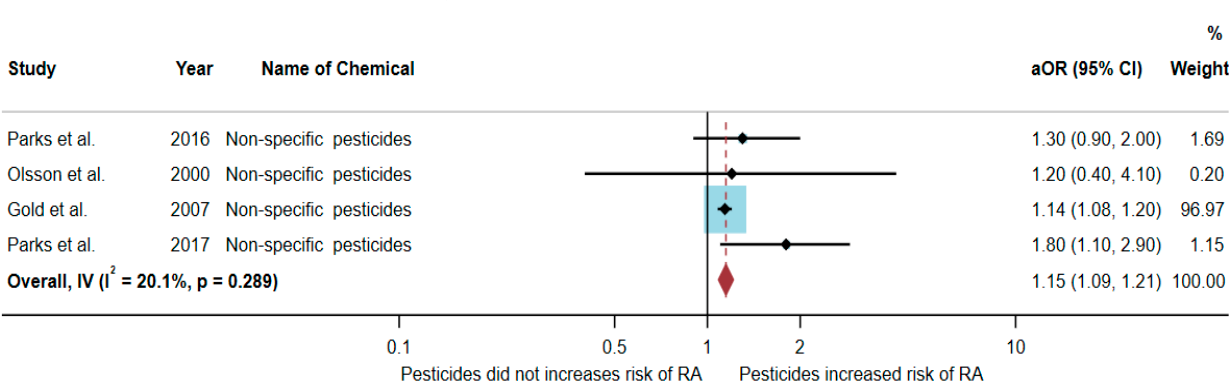
Figure 5. The association between exposure to non - specific pesticides and RA development [20,22– 24]. aOR, adjusted odds ratio; 95% CI, 95% confidence interval. aOR, adjusted odds ratio; 95% CI, 95% confidence